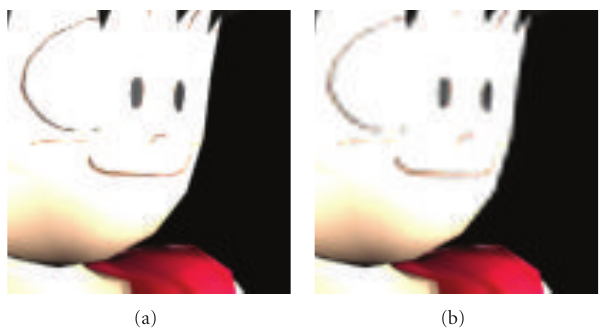
Figure 13: Goku : (a) detail of the character’s face and (b) same detail corrupted by the loss of the 23th packet.